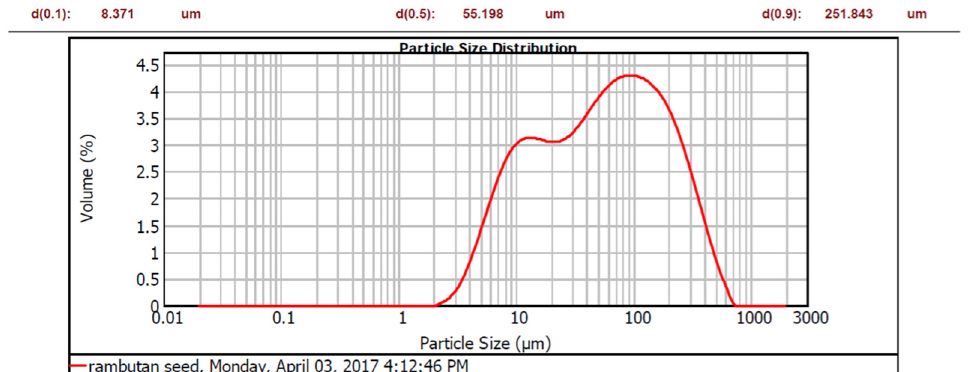
Figure 2. Particle size of Nephelium lappaceum seeds.